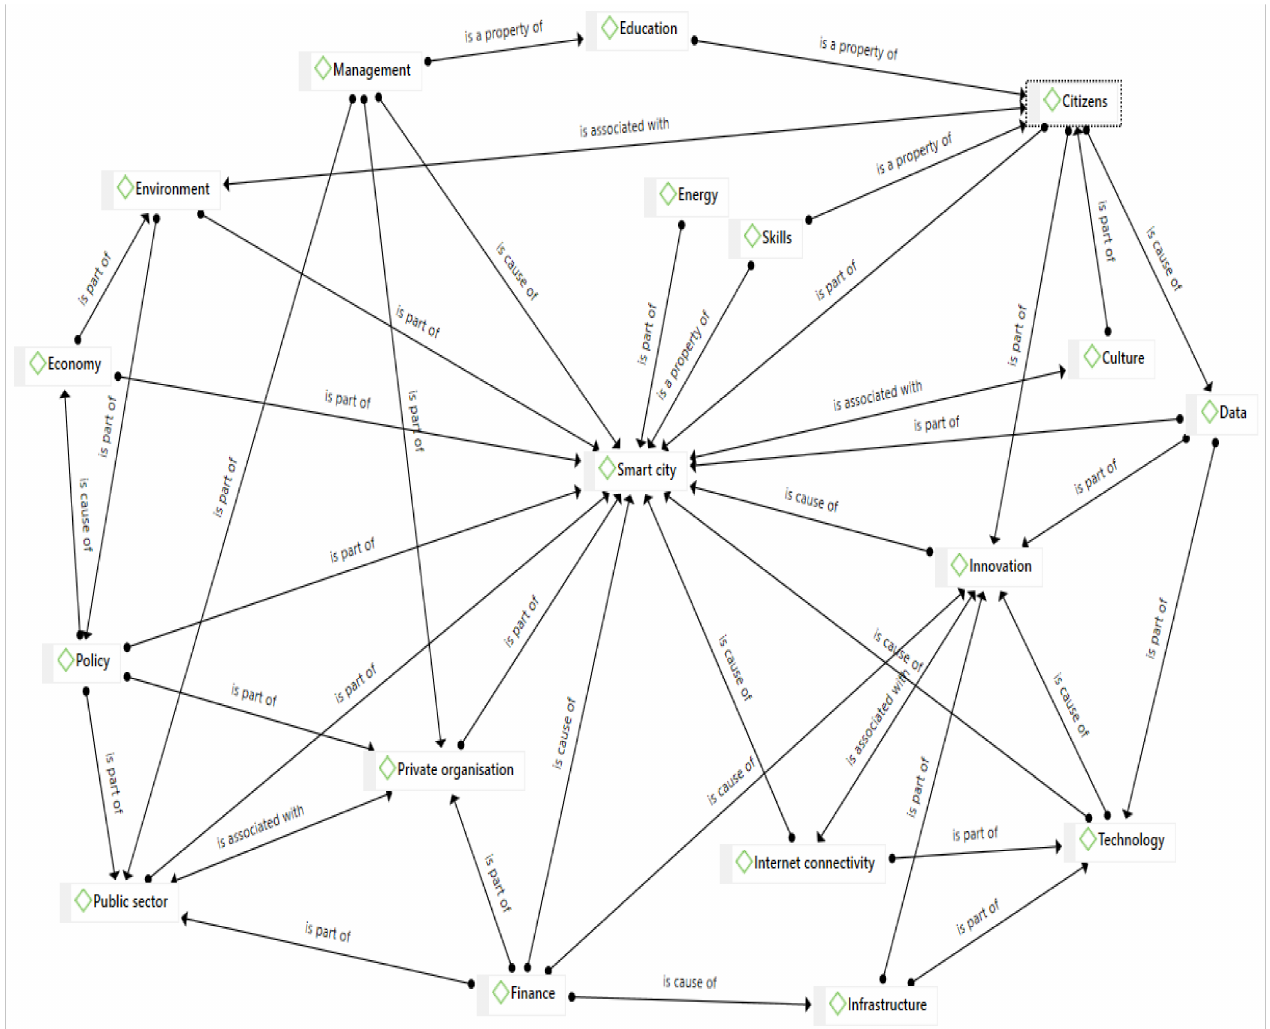
Figure 2. Smart city key factors network